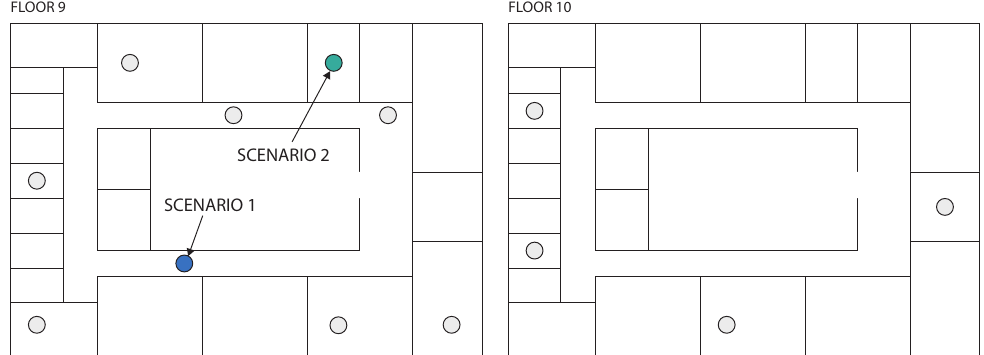
Figure 5. The two floors of the hardware testbed with the 13 used nodes illustrated at their locations. Two scenarios of 12 nodes were considered: scenario 1 includes the 11 grey nodes and the blue node while scenario 2 includes the 11 grey nodes and the green node.